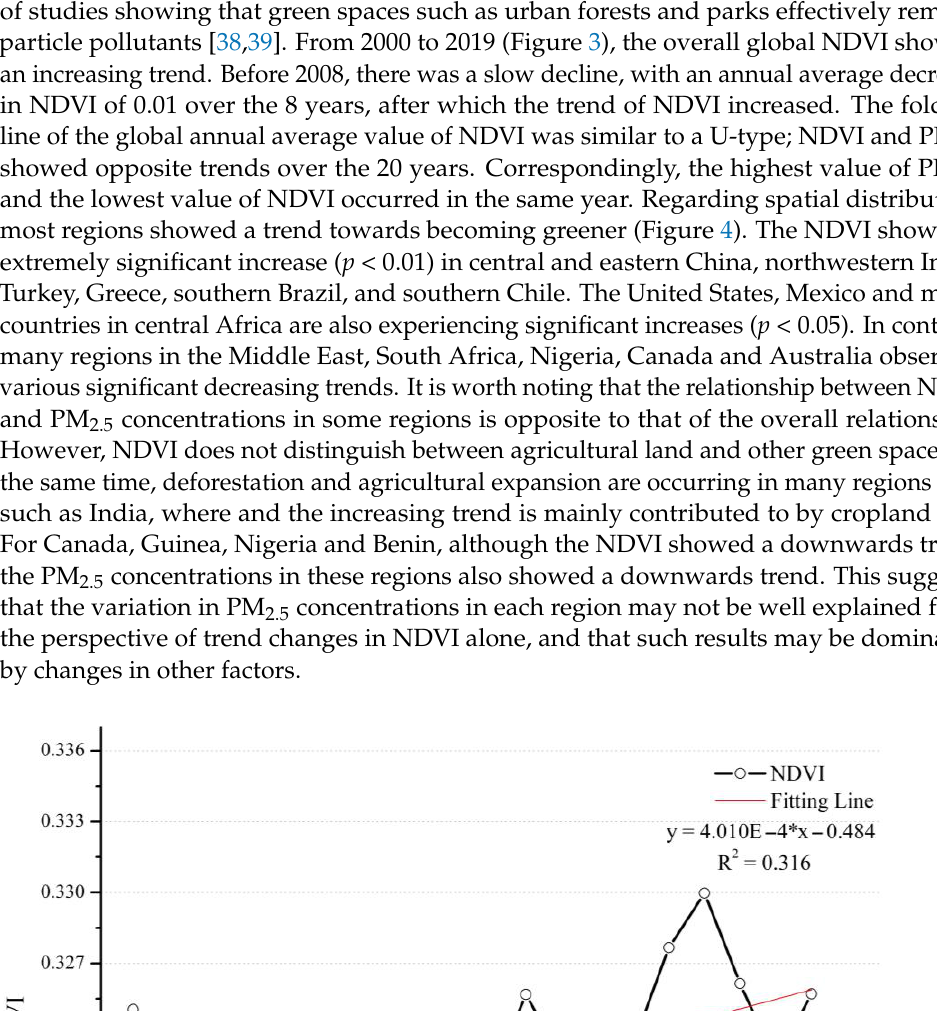
Figure 4. Spatiotemporal trends of NDVI worldwide (2000 – 2019). Wet deposition is one of the most efficient ways to remove pollutants from the at- mosphere [42], and precipitation is the most common type of wet deposition method. During this twenty-year period, more than half of the areas did not show a significant increase or decrease in precipitation. However, in other areas, there was a large spatially stratified heterogeneity in the trends of precipitation across the globe (Figure 5). Precipi- tation in the northern and eastern regions of the U.S. and Alaska showed increasing trends of varying significance, and the corresponding regional PM 2 . 5 concentrations were on the decline, suggesting an important local correlation between precipitation and PM 2 . 5 con- centration. A similar situation occurred in Canada, Finland, Vietnam, and parts of western Africa. However, many areas, such as India, Saudi Arabia and Indonesia, showed a trend of increasing precipitation, but also an increasing trend in PM 2 . 5 concentration; the increase in precipitation did not seem to have a visual impact on the decrease in PM 2 . 5